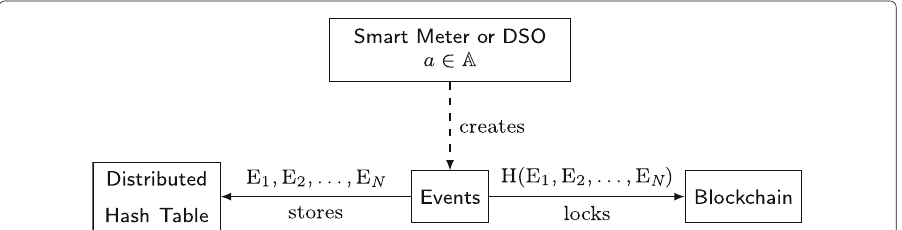
Fig. 2 A smart meter or DSO a ∈ A creates a series of one or more events E 1 ,E 2, ... , E N and stores the event data in a distributed hash table. The corresponding hash is locked in the blockchain. In order to retrieve a list of events, the hashes are read from the blockchain and the hash is used as the key to load event data from the storage